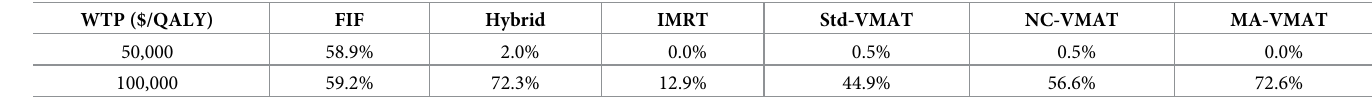
Table 5. Probability of being more cost-effective than SOC for advanced